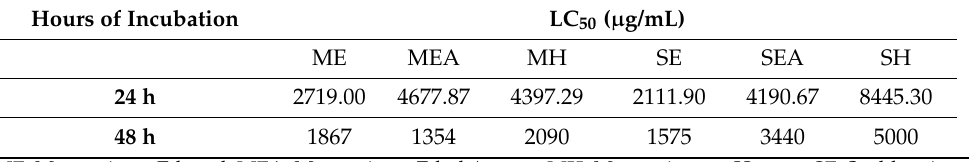
Table 2. The LC 50 sequence of samples that were lowest or showing the highest cytotoxicity to the lowest cytotoxicity is SE, ME, SEA, MH, MEA, and SH at 24 incubation hours; and MEA, SE, ME, MH, SEA, and SH at 48 h (Table 2). Table 2. LC 50 value of C. lentillifera in a cytotoxicity test in BUD-8 normal cell lines. Hours of